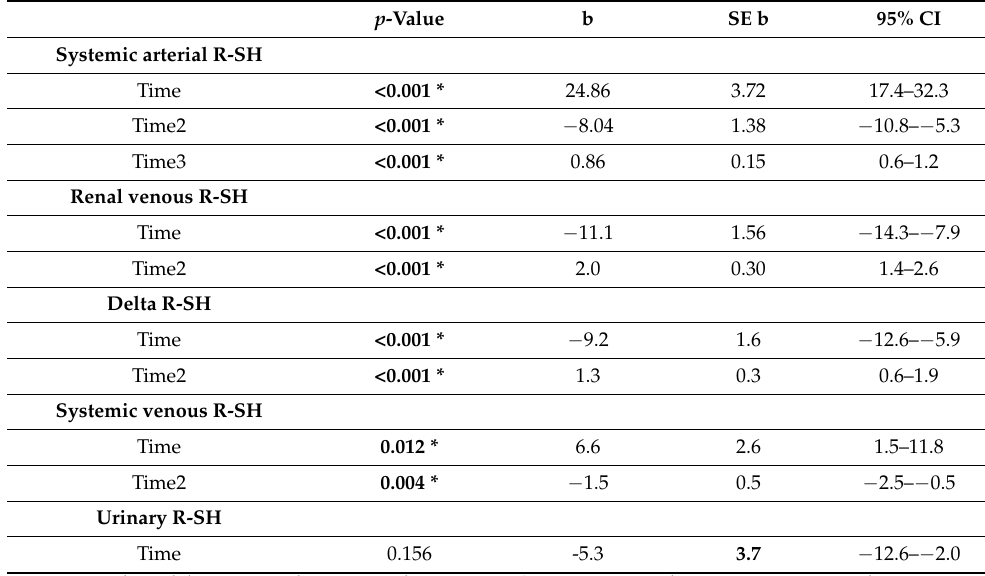
Table 2. Results of linear mixed models: time as covariate.